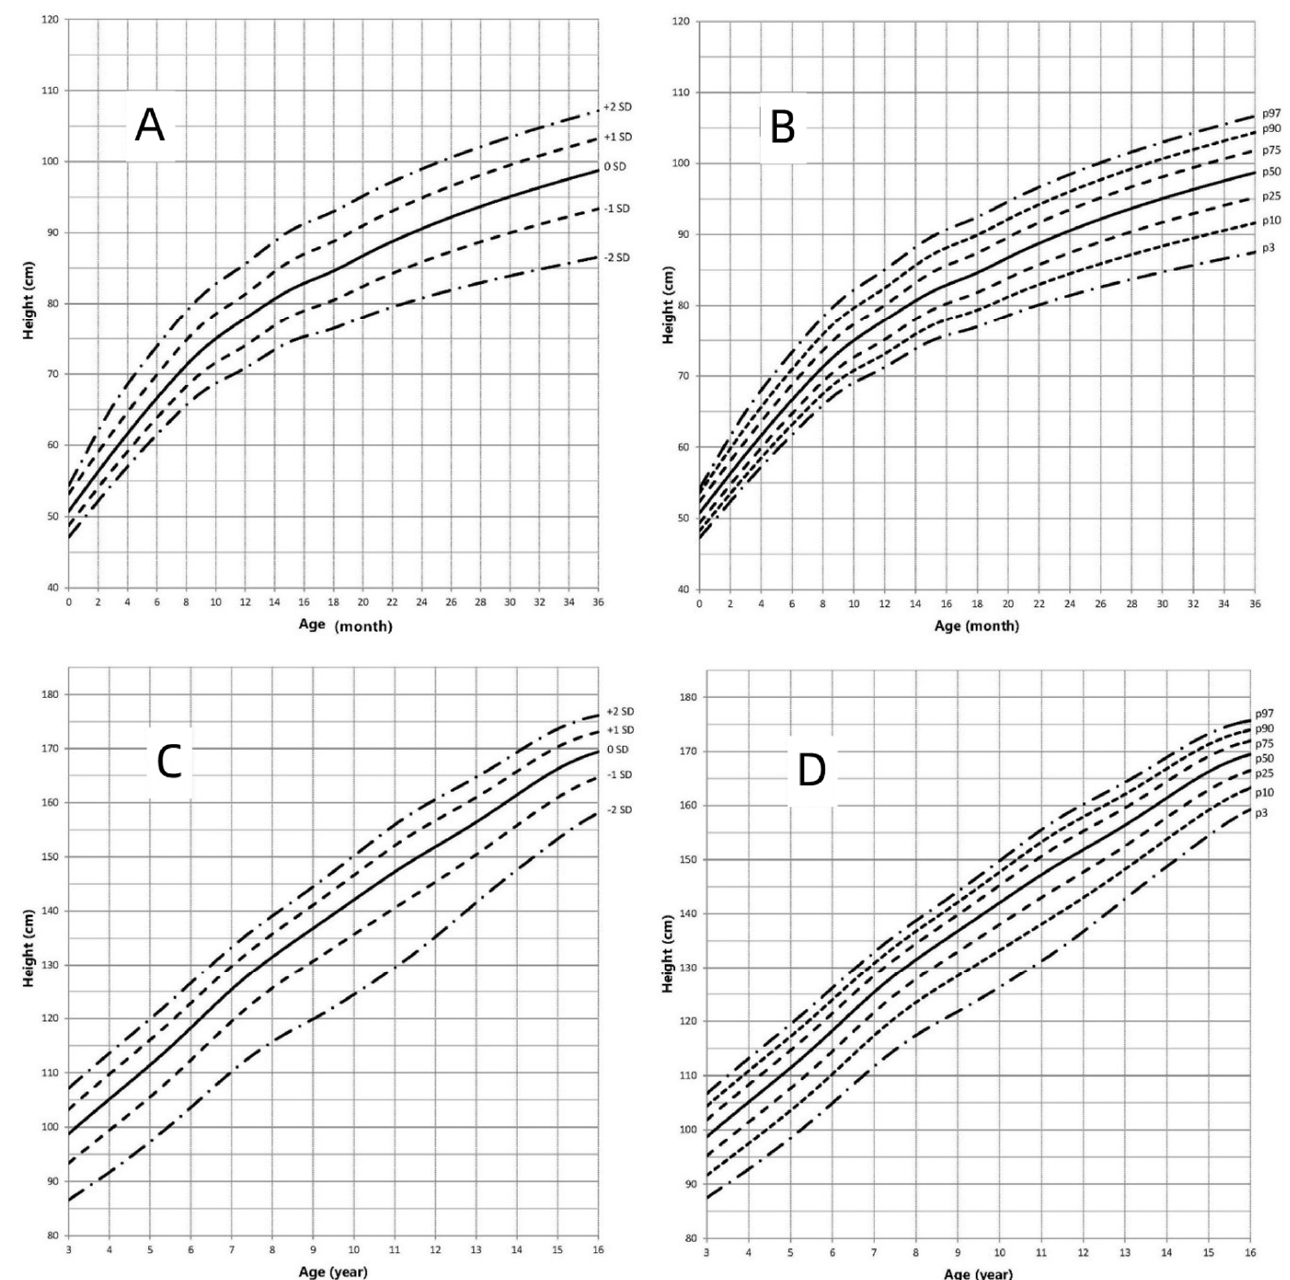
Figure 2. Height in children with AIS (0–16 years old). ( A ): Standard deviation curve (0–36 months old); ( B ): Percentile curve (0–36 months old); ( C ): Standard deviation curve (3–16 years old); ( D ): Percentile curve (3–16 years old).